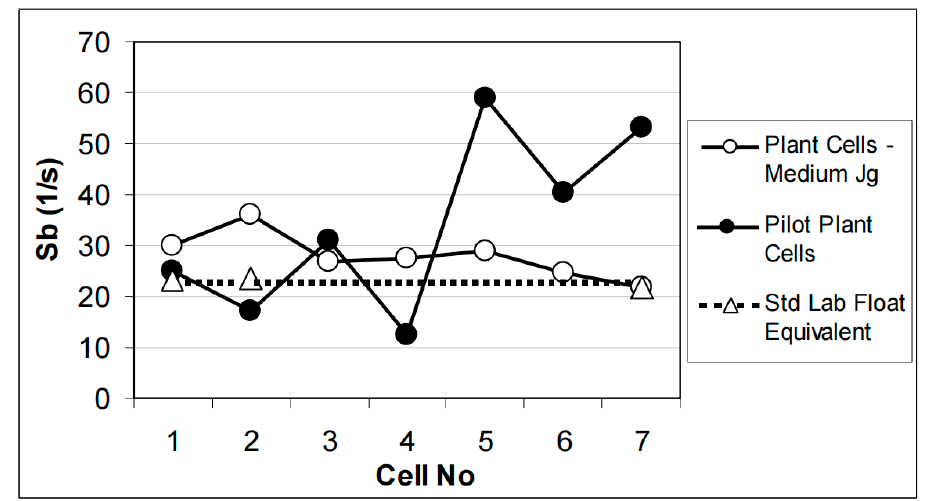
Figure 6. Down the bank S b values for the first seven pilot and plant cells.